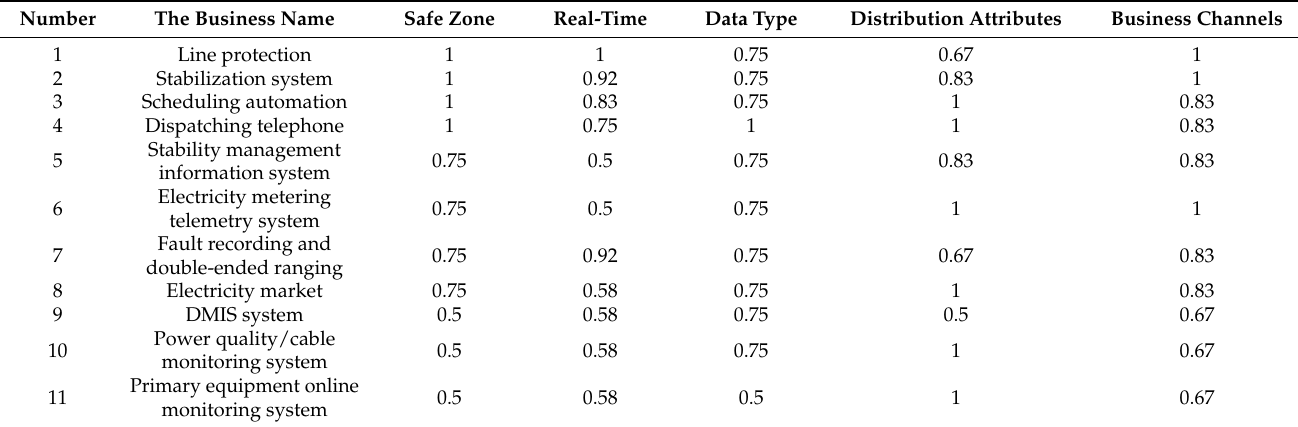
Table 3. Indicator items control point